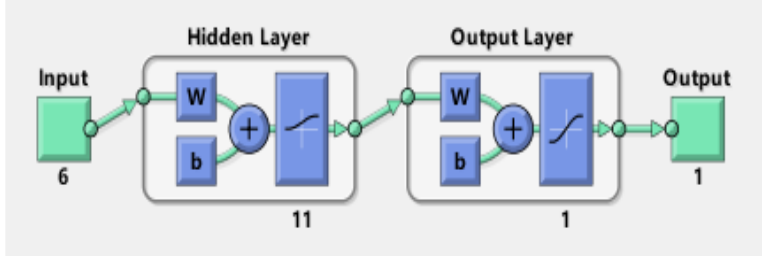
Figure 4. The simple flowchart of the BPNN algorithm.